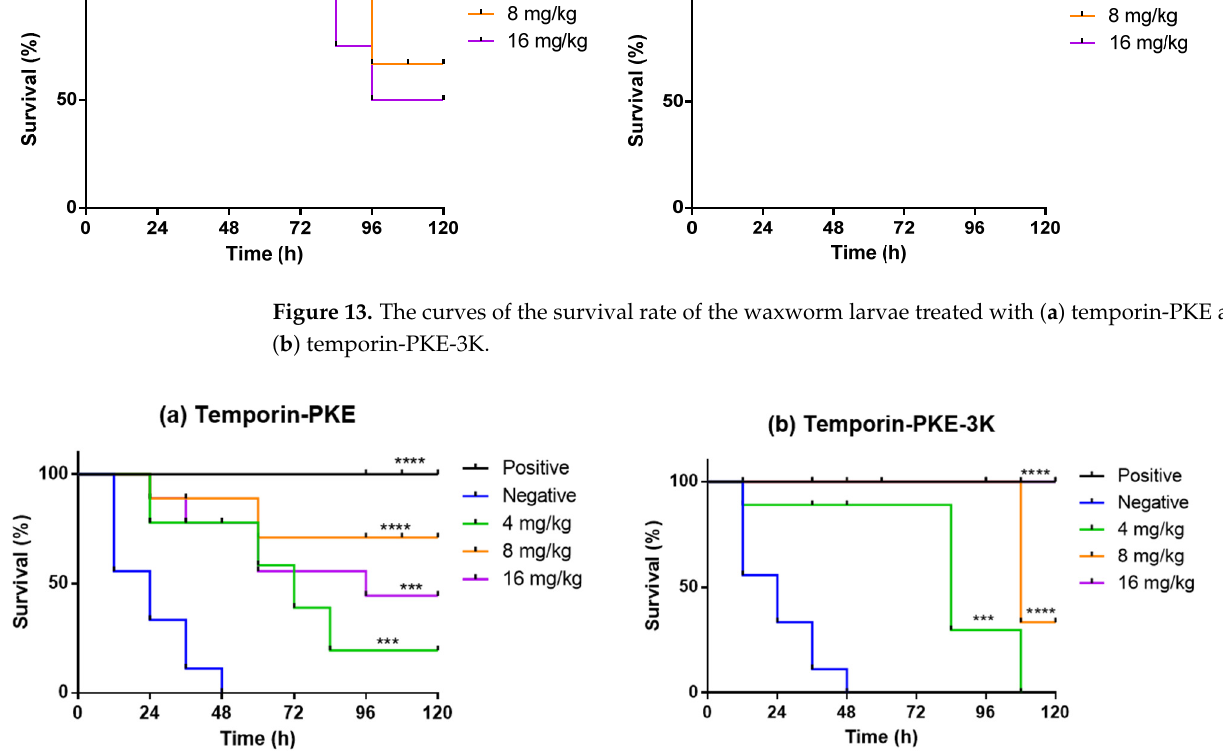
Figure 14. The curves of survival of ( a ) temporin-PKE and ( b ) temporin-PKE-3K in wax worm larvae infected by MRSA. PBS and 50 mg/kg Vancomycin were used as the negative control and positive control, respectively. The data were analysed by the survival analysis and curve comparison test comparing the survival rate of different concentrations of peptides with that of the negative control group. The significance was indicated by **** ( p < 0.0001) and *** ( p < 0.001).